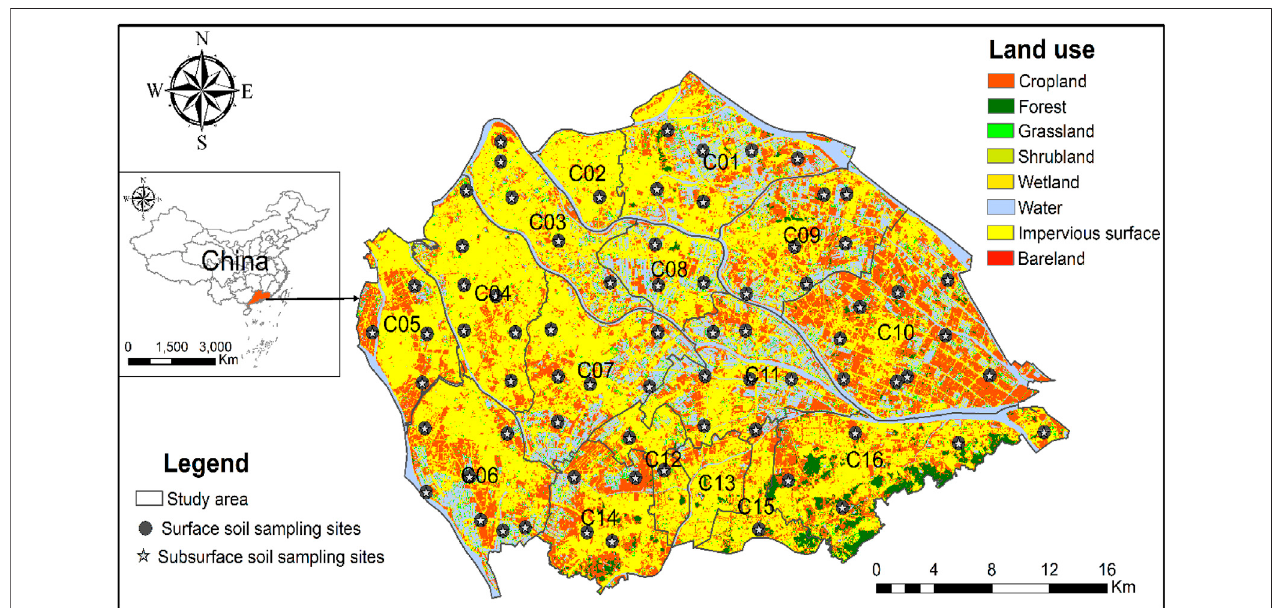
FIGURE 1 | Distribution of sampling sites in the study